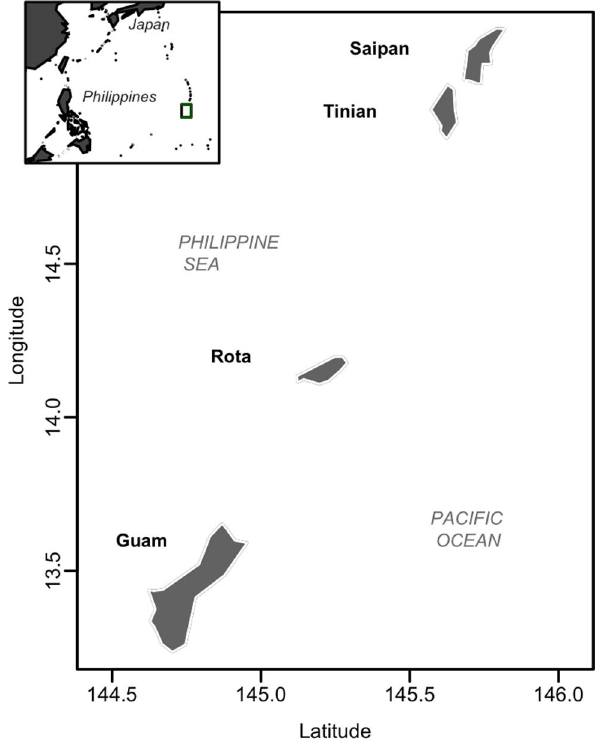
Figure 1. Map of the Mariana Islands. The locations of Guam and Saipan, the two islands used in this study, are shown.